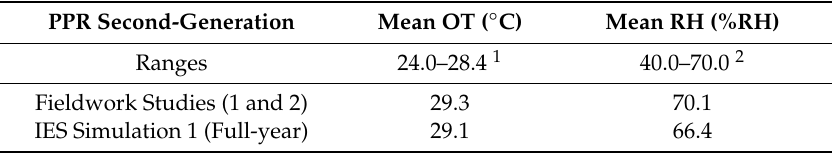
Table 6. Fieldwork studies and IES 1 results for the PPR second generation